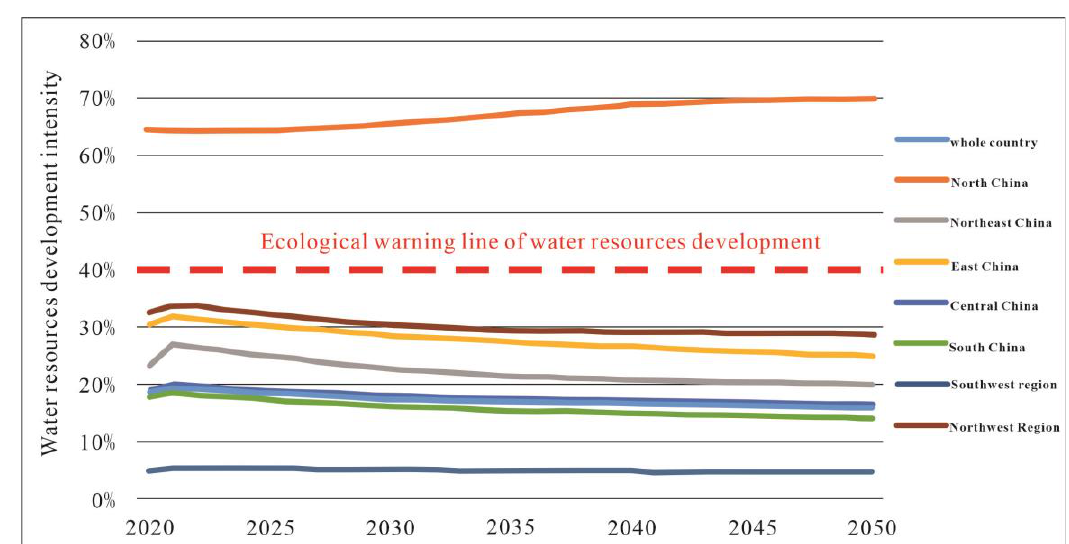
Figure 6. Trend of water resources’ development intensity in each geographical division from 2020 to